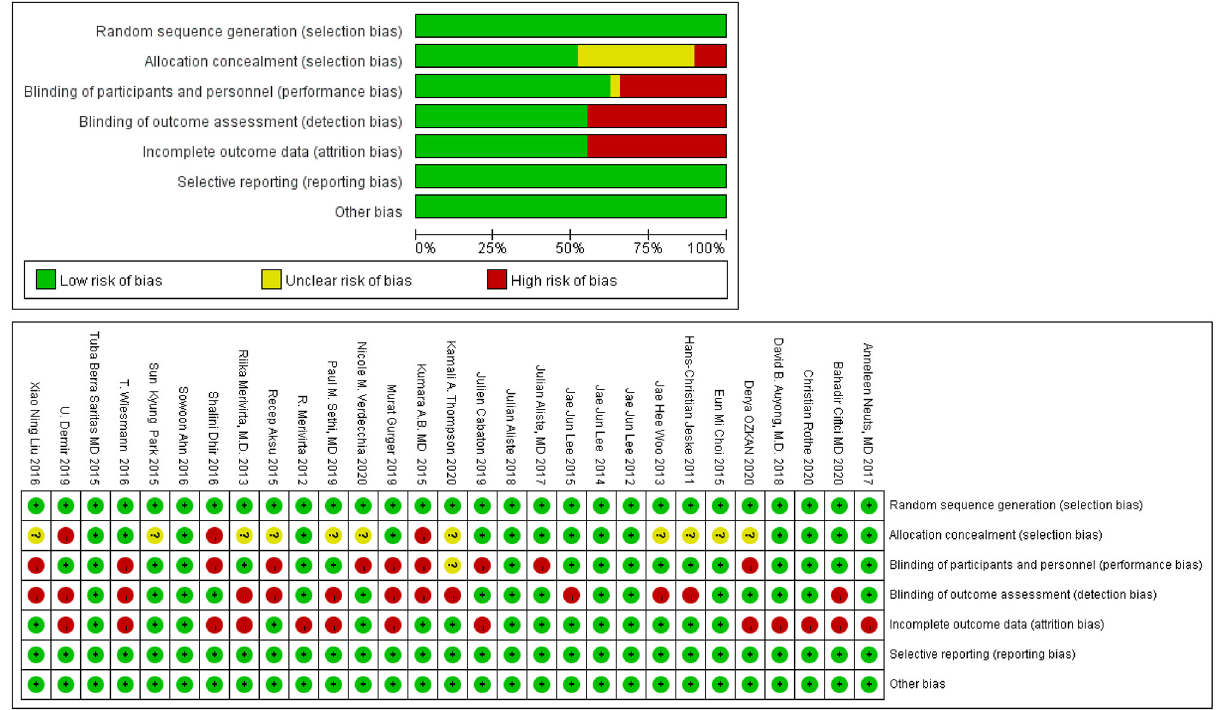
FIGURE 3 | Quality assessment.